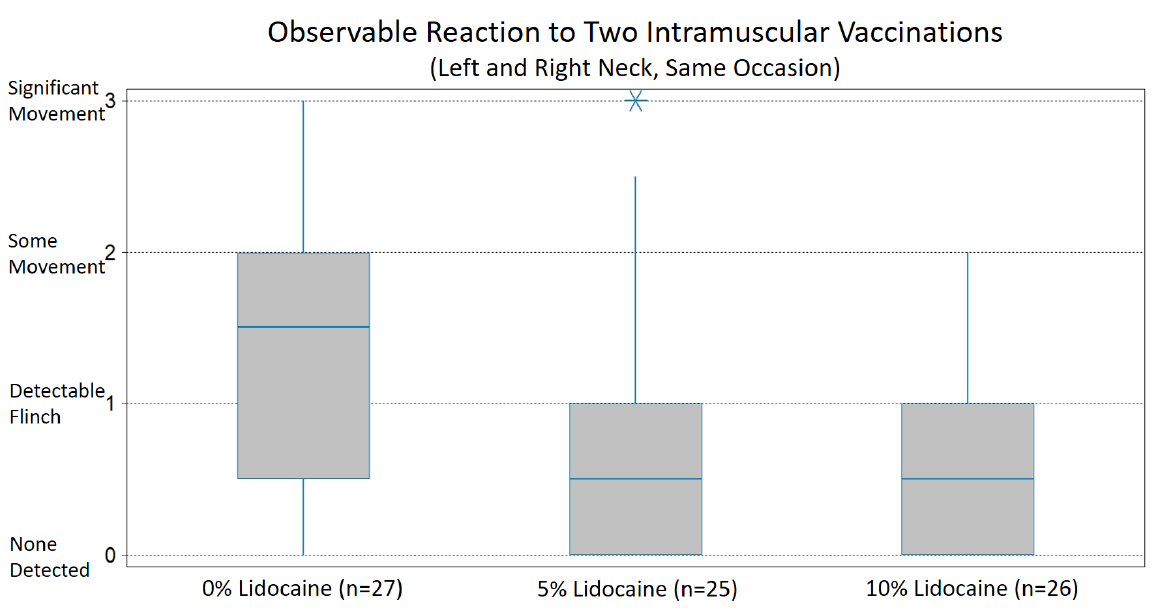
Figure 2. Box spans middle half of data, bisect line = median, whiskers span typical data, * = outlier.